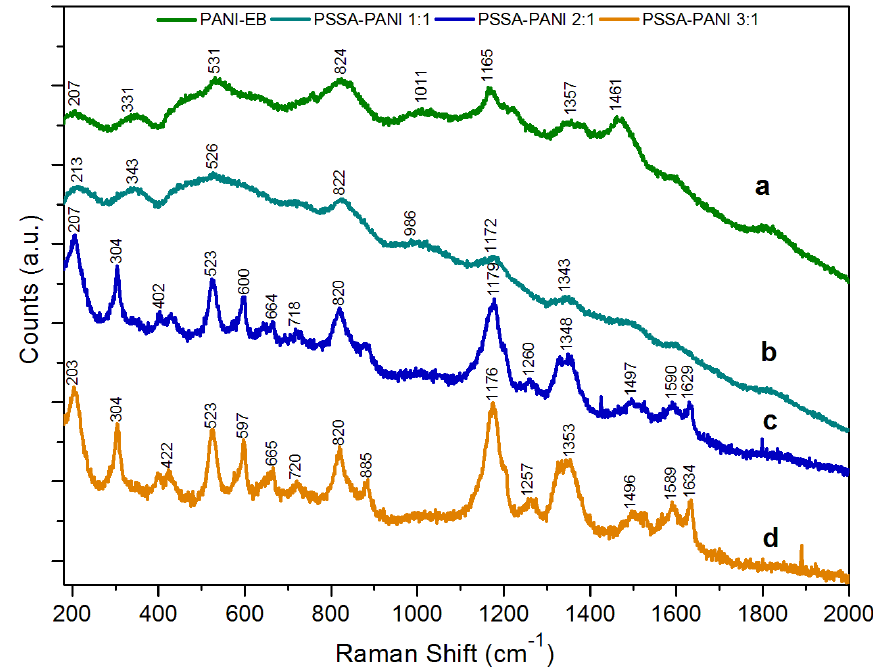
Figure 3: Recorded Raman spectra for (a) PANI-EB, (b) PSSA-PANI 1:1, (c) PSSA-PANI 2:1 (d) PSSA-PANI